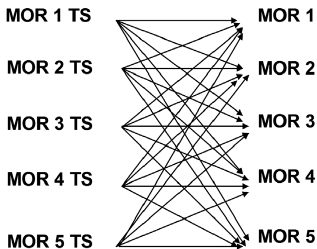
Figure 5. Retained-E of the refractory castables after thermal shock of ΔT = 800 °C for small and large specimens.